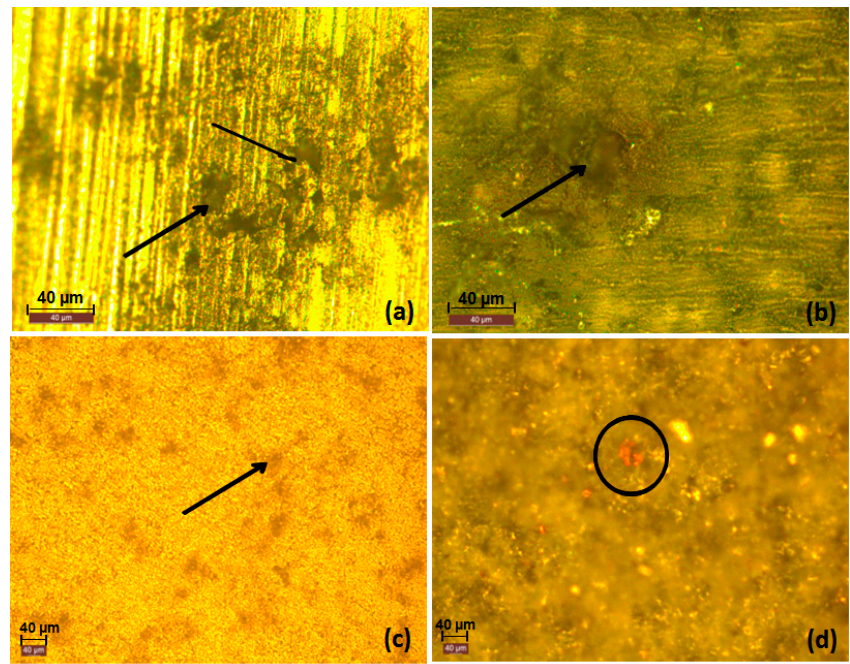
Figure 11. Comparison of corrosion current density values from AP measurements for the coated test specimens.